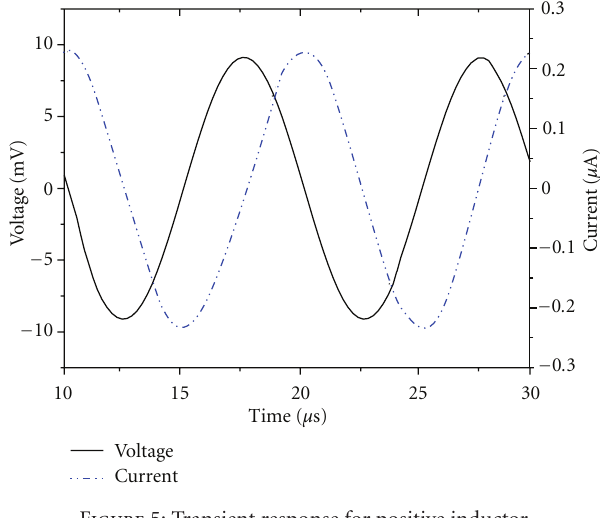
Figure 5: Transient response for positive inductor.